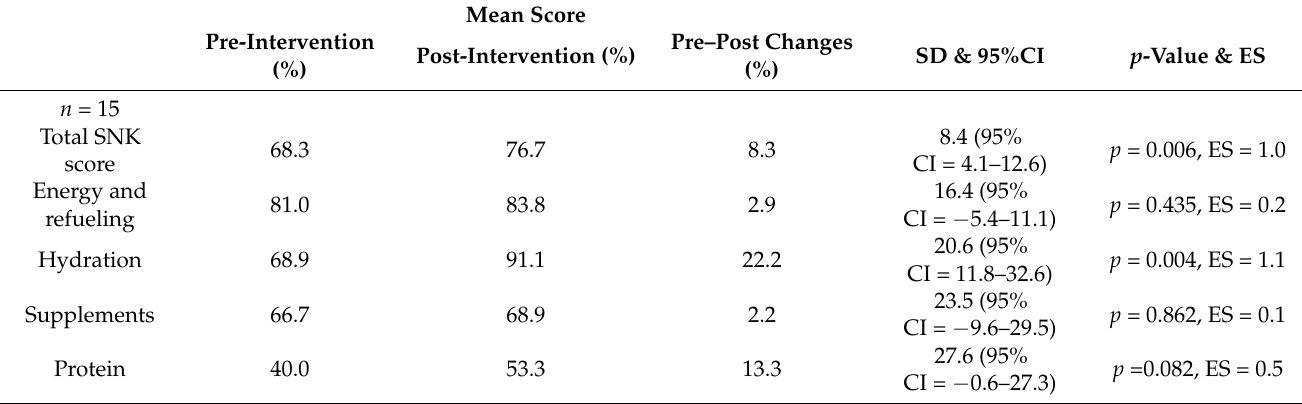
Table 2. Sports nutrition knowledge (SNK) total score, topic scores, and change scores pre- and post-educational sessions. Mean